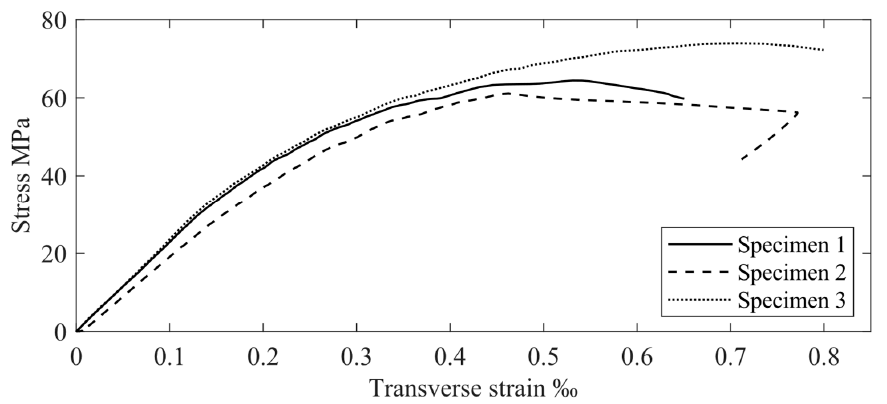
Figure 14. Experimental σ c – ε trans dependences for HSC (following [6]). Table 7. Experimental values of maximum elastic strains, ultimate transverse strains, and Poisson’s ratios for HSC (following [6]).